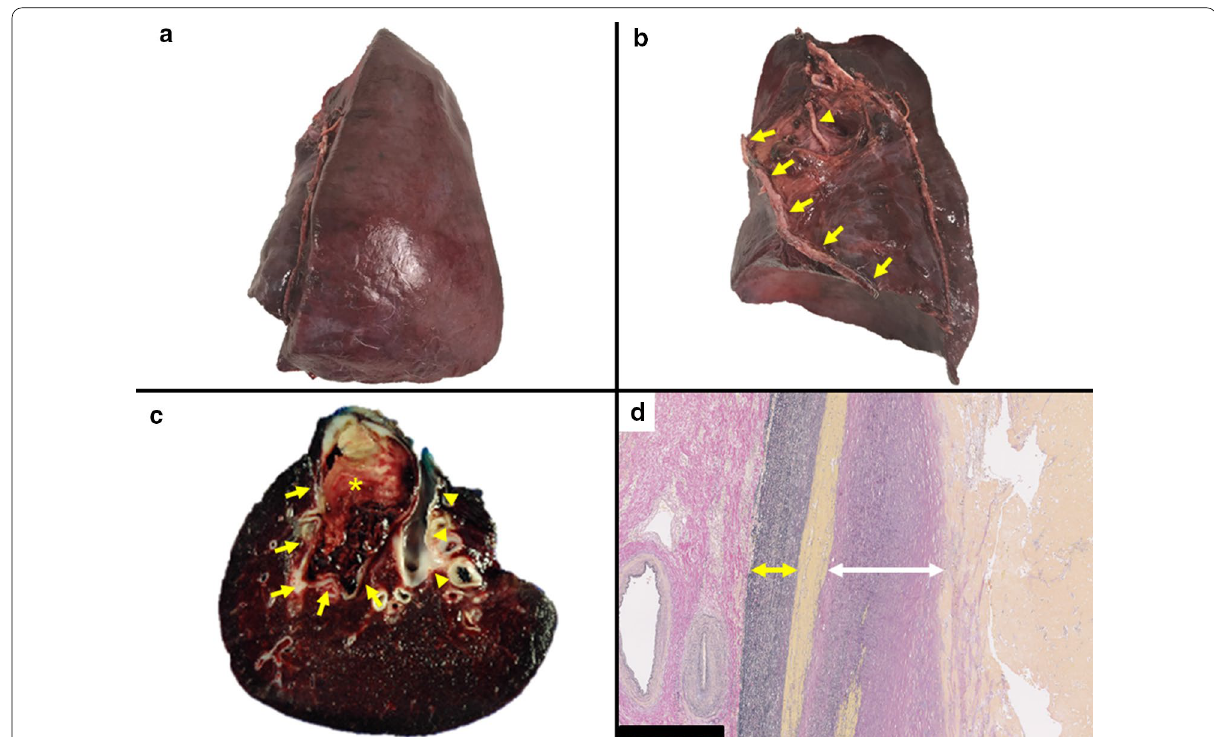
Fig. 2 Pathological findings. a Photograph of the resected left lower lobe showing congestion (frontal view). b Photograph showing the aberrant artery including pulmonary ligament (yellow arrows), which was large and thick compared with the left inferior pulmonary vein (yellow arrowhead) (hilar view). c Photograph of the aberrant artery (yellow arrows), which was larger than the left inferior pulmonary vein (yellow arrowheads), and the thrombus was filled in the lumen (asterisk). d Elastica van Gieson-stained sections showing the aberrant artery with thick elastic lamina and dissected between the tunica media (yellow double-headed arrow) and intima (white double-headed arrow). Scale bar